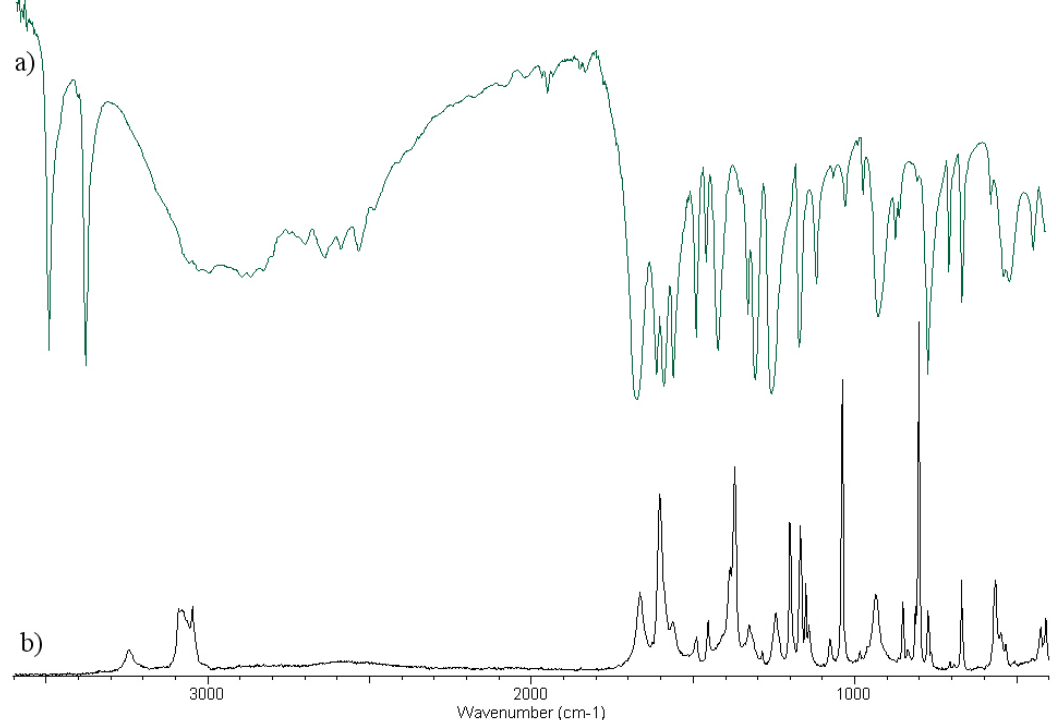
Figure 1. The FT-IR (a) and FT-Raman (b) spectra of o -aminobenzoic